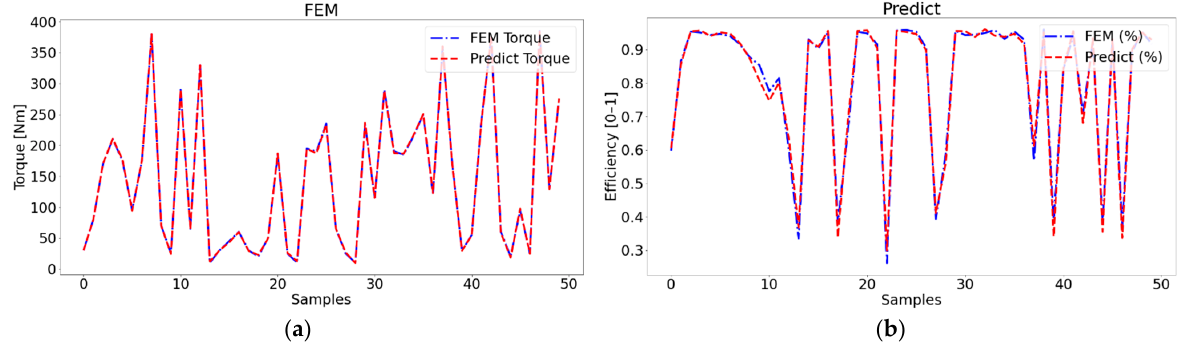
Figure 10. Comparison between FEM and prediction for 50 samples obtained with Model-1: ( a ) torque; ( b ) efficiency.